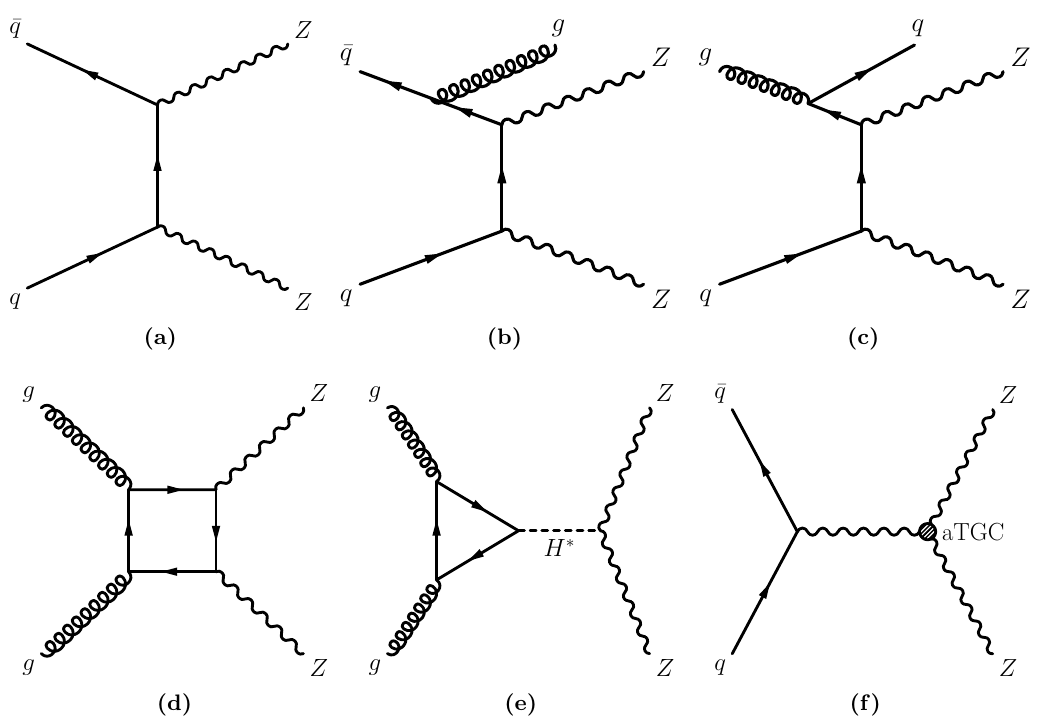
Figure 1 . Representative Feynman diagrams for ZZ production at the LHC: (a) lowest-order t -channel qqZZ production; (b) production of ZZ plus one parton through the q (cid:22) q initial state; (c) production of ZZ plus one parton through the qg initial state; (d) ggZZ production with a fermion loop; (e) ggZZ production involving an exchange of a virtual Higgs boson; (f) s -channel production with